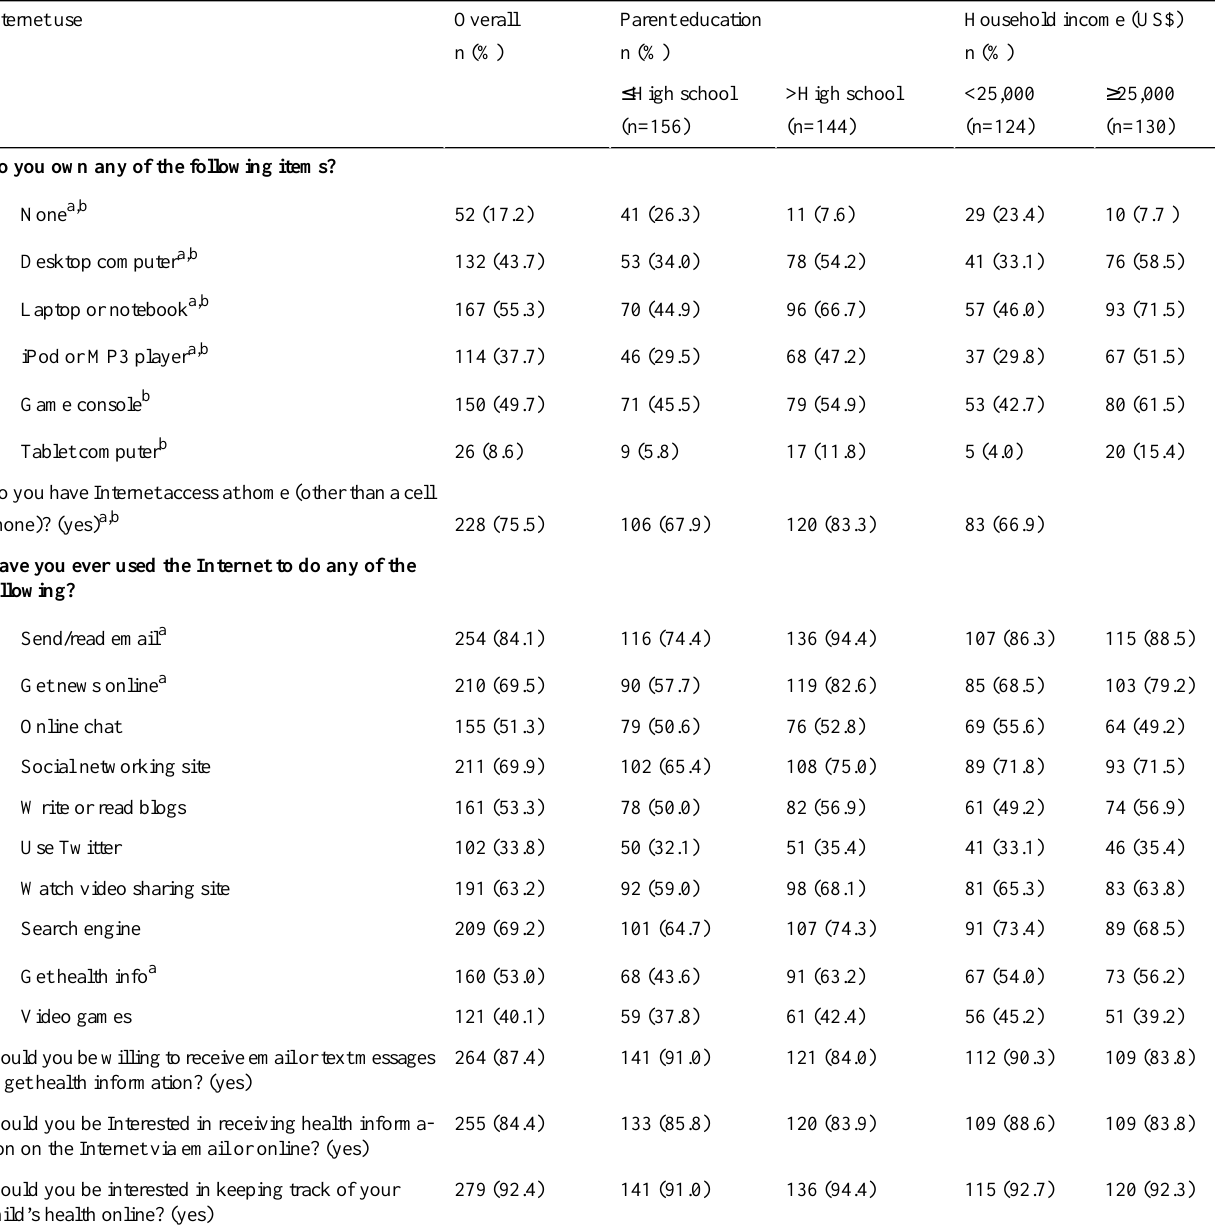
Table 4. Participant Internet use by education and income (N=302).